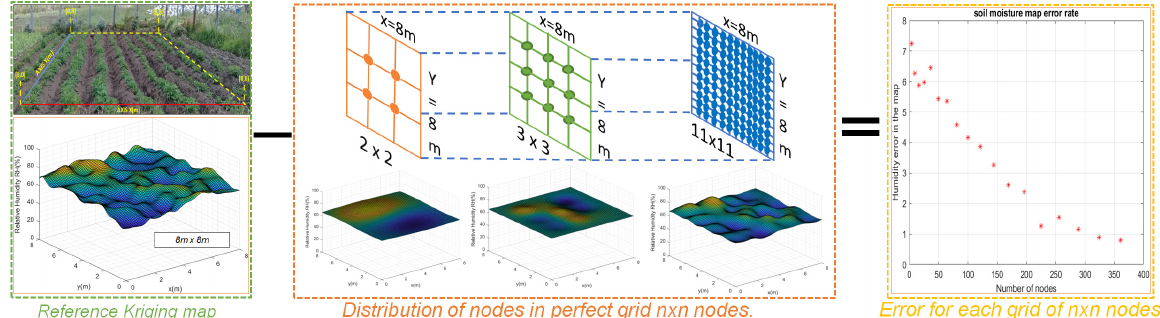
Figure 7. Proposed methodology for the calculation of the error of the n × n nodes with reference to the initial reference map.